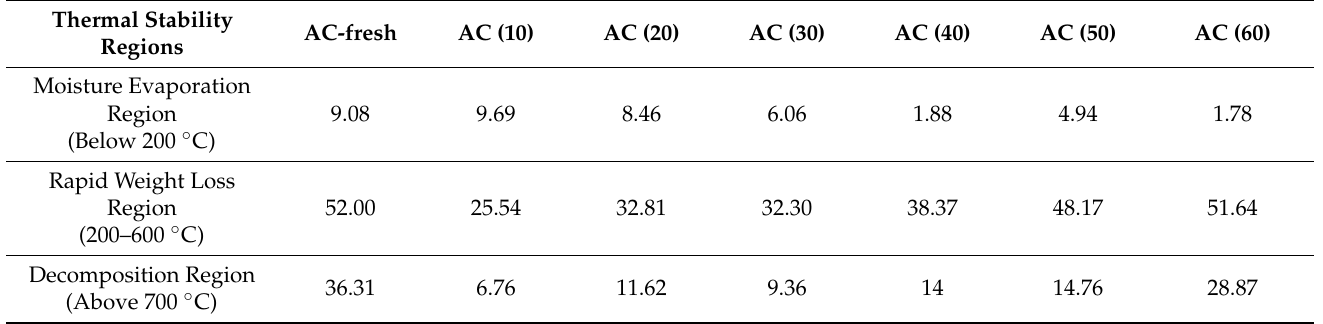
Table 2. Thermal stability regions and respective weight loss for fresh and functionalized